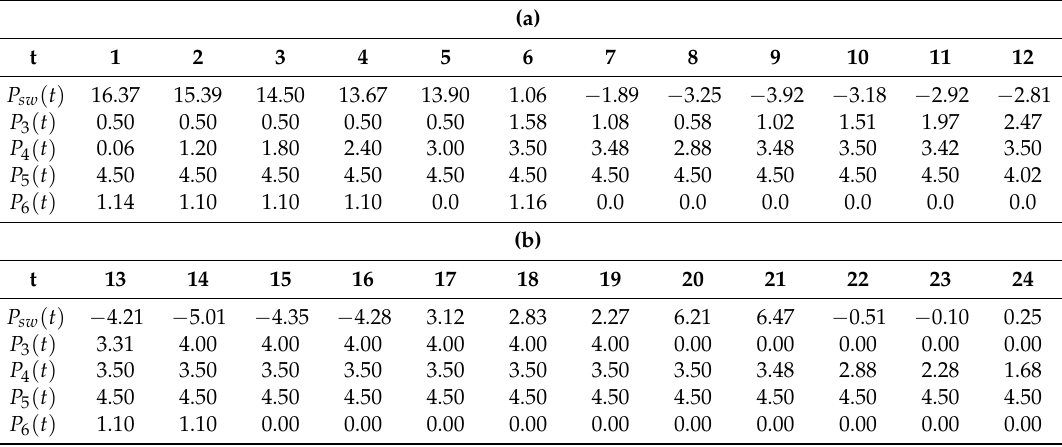
Table 7. ( a ) Real power injections (MW) during 1:00 a.m. − 12:00 p.m. ( b ) Real power injections (MW) during 13:00 p.m. − 24:00